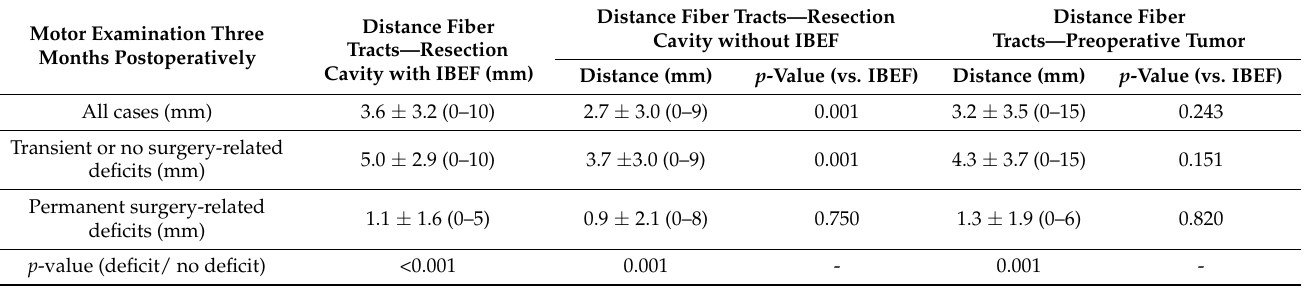
Table 1. Distance between the motor eloquent fiber tracts and the intraoperative magnetic resonance imaging (MRI) resection cavity. This table shows the distance between the motor eloquent fiber tracts and the resection cavity depicted in the intraoperative MRI. Cases without surgery-related deficits at the 3 month follow-up (FU) (including patients with transient surgery-related deficits) are compared with cases with permanent surgery-related deficits at the 3 month FU (including patients with surgery-related deficits lost to FU). Distances are shown for measurements with IBEF, without IBEF, and preoperative measurements.